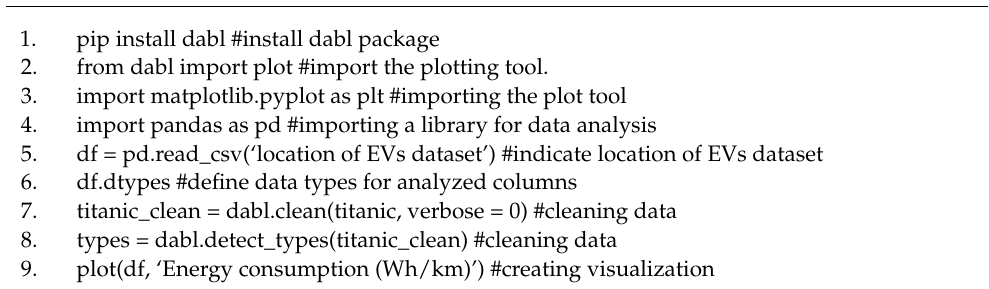
Algorithm 1: Data processing of EVs in